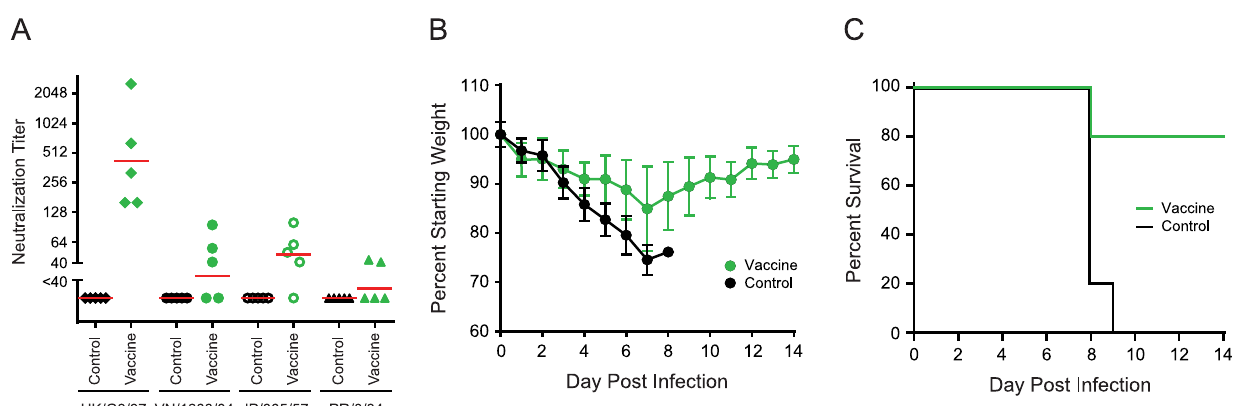
Fig 2. Heterosubtypic HA immunizations provide cross-protection against influenza virus challenge. Mice (5 per group) were immunized once with A/chicken/Hong Kong/G9/1997 (HK/G9/97) (H9) HA, followed by one boost with A/Vietnam/1203/2004 (VN/1203/04) (H5) HA and one boost with A/ Singapore/1/1957 (H2) HA, then challenged with 5 LD 50 A/Puerto Rico/8/1934 (PR/8/34). Mice were observed for 2 weeks for body weight loss and/or death after challenge. (A) Neutralization titers of mice sera post-immunization. (B) Average percentage change in body weight post-challenge. Bars: standard deviations. (C) Mice survival curves post-challenge. Control: mock immunization (without influenza HA); Vaccine: immunization with influenza HA.